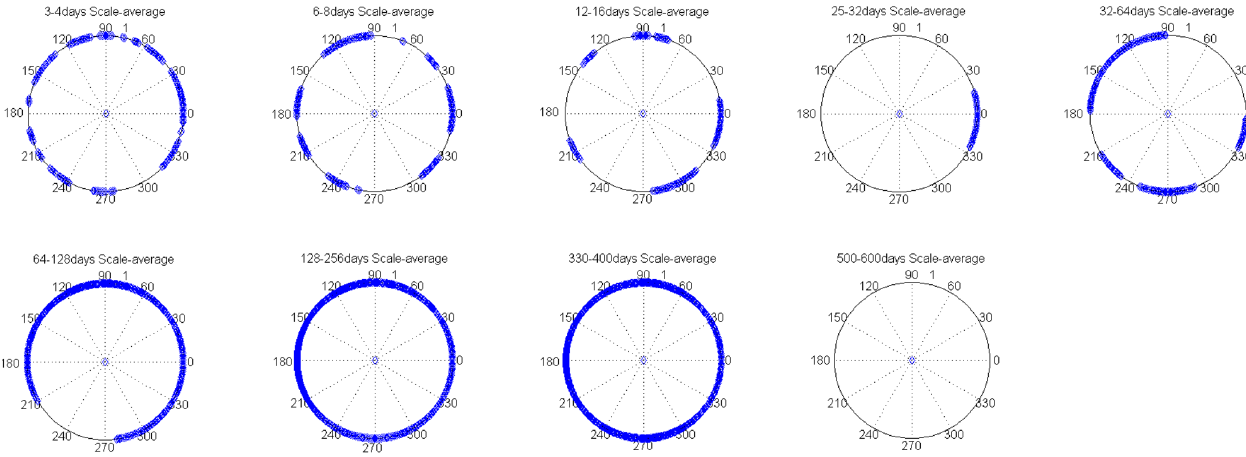
Fig. 2. Scale-average behaviour along a year (from wavelet analysis) for CVD 0–64 years group. Each plot represents a turn around the Sun. An angle of 0 degrees corresponds to 1 January of each year and every year is represented for a complete turn of 360 degrees. 90 degrees is around spring equinox, 270 degrees is around autumn equinox and 180 degrees to summer solstice.